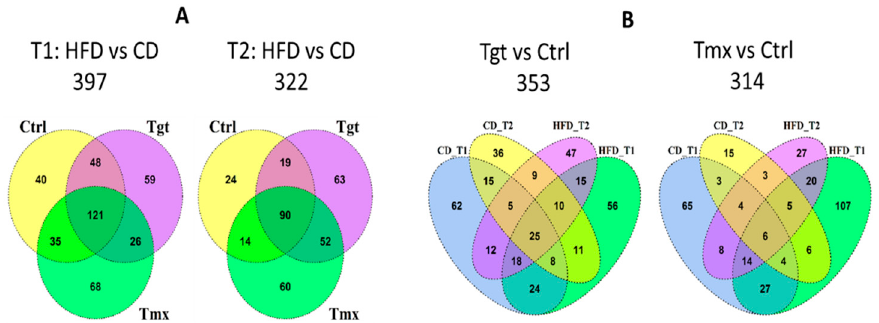
Figure 4. Venn diagrams of metabolites significantly changed in abundance among groups. ( A ) overlap of metabolites significantly changed in abundance at T1 and T2 for HFD vs. CD; ( B ) overlap of metabolites significantly changed in abundance for Tgt vs. control and Tmx vs. Ctrl. Diets: standard diet (CD); high fat diet (HFD); Times: T1, 78 days of age; T2, 190 days of age; Treatments: Ctrl, control; Tgt, targretin; Tmx, tamoxifen.